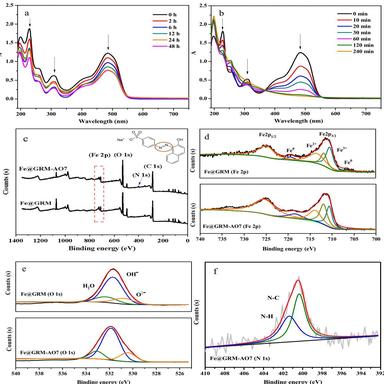
(a) UVevis spectra of AO7 at various times in the Fe@GRM; (b) UVevis spectra of AO7 at various times in the presence of Fe@GRM/PS; (c)The XPS surveys of before and after removal AO7 by Fe@GRM/PS; (d) Fe 2p spectra of Fe@GRM; (e) O1s spectra of Fe@GRM; (f) N1s spectra of Fe@GRM after removing AO7.